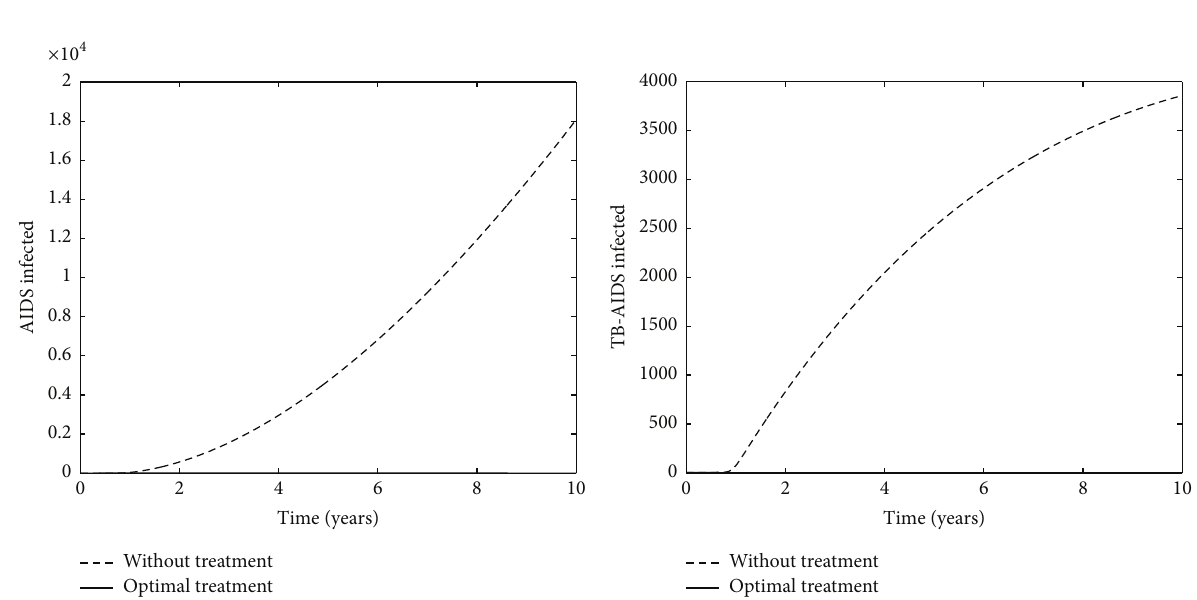
Figure 14: The dynamics of 𝐴 ℎ and 𝐴 ℎ𝑡 using controls 𝑢 ∗ 1 and 𝑢 ∗ 2